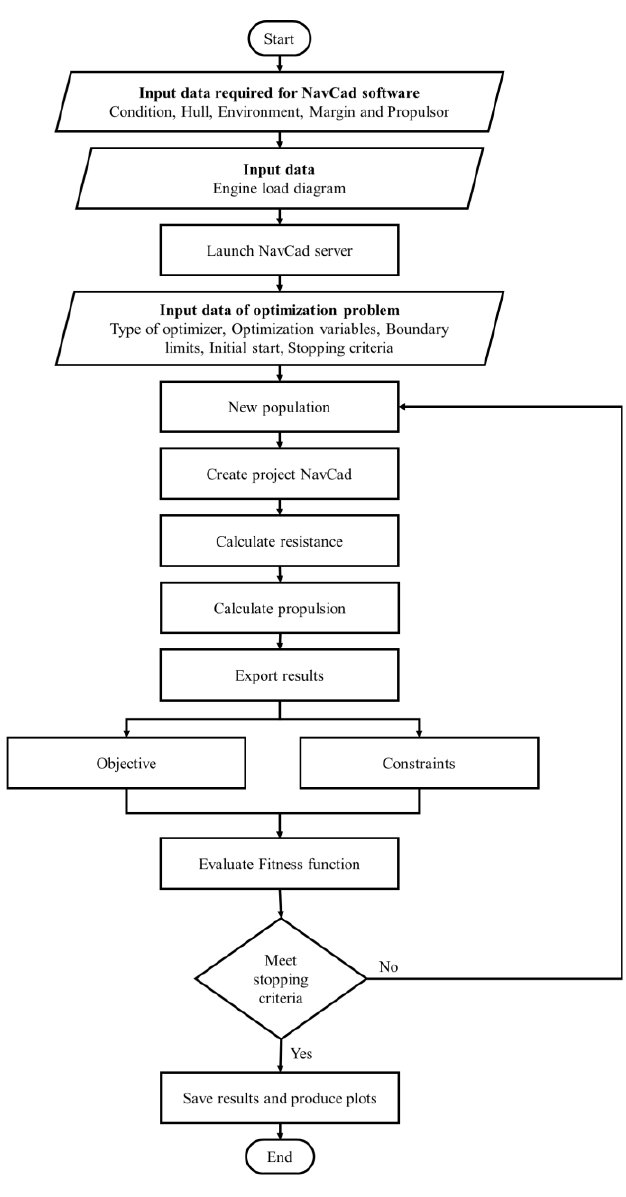
Figure 4. Schematic diagram of optimization tool in calm water.